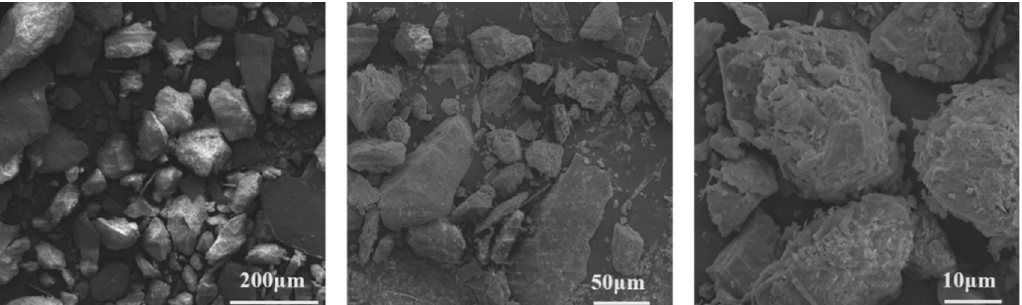
Figure 3. SEM images of iron tailings sand.